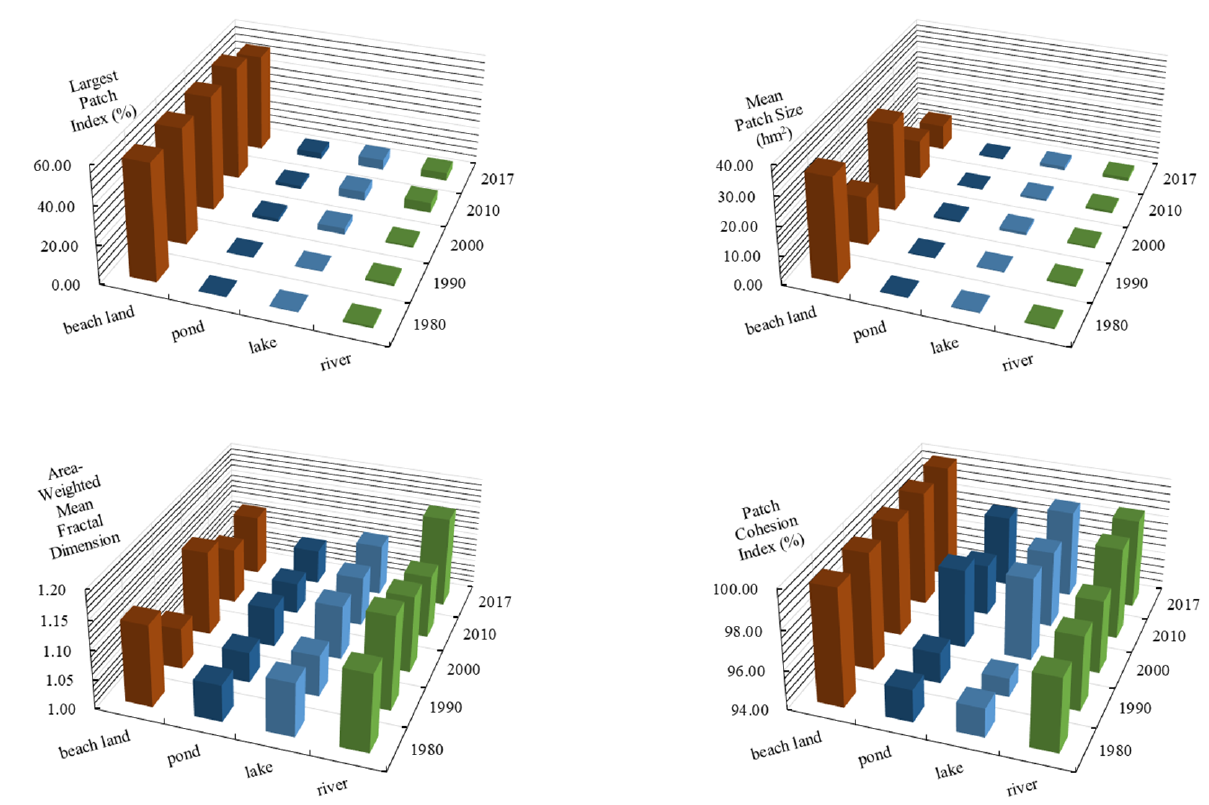
Figure 6. Changes in the landscape indexes (LPI, MPS, FRAC_AM, and COHESION) at the class scale in the Xiong’an New Area from 1980 to 2017.